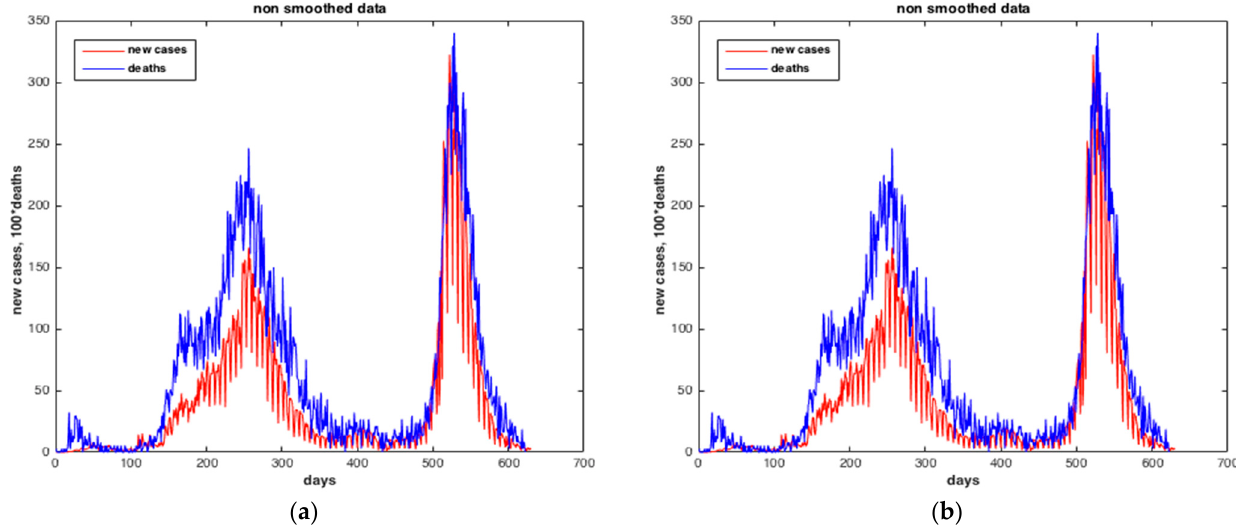
Figure 16. Comparison between the number of confirmed cases and the number of deaths. ( a ) Non- smoothed data. ( b ) Smoothed data. The results furnished by collocation method.